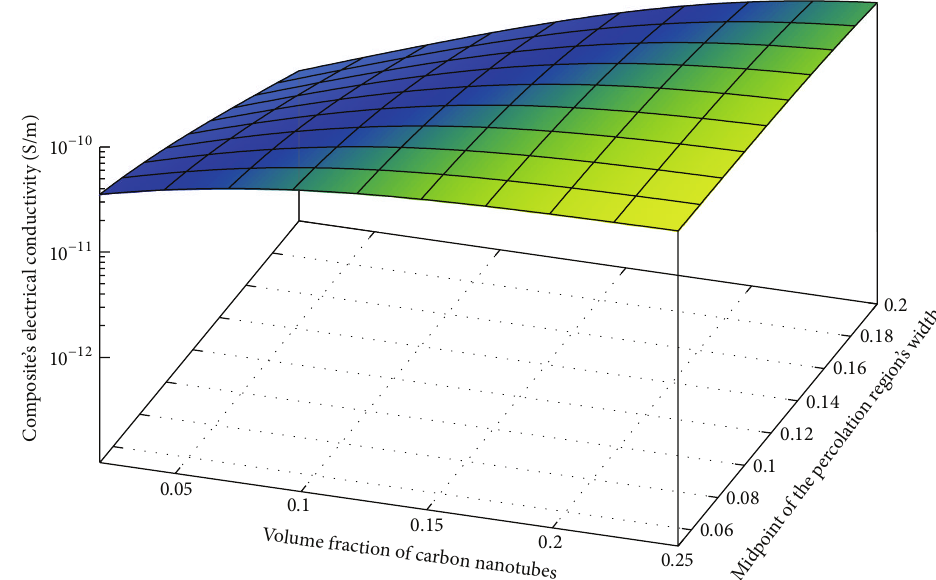
Figure 25: DC electrical conductivity of the nanocomposite at varying both the midpoint of the percolation region’s width and the volume fraction of the filler (Sigmoidal function model).